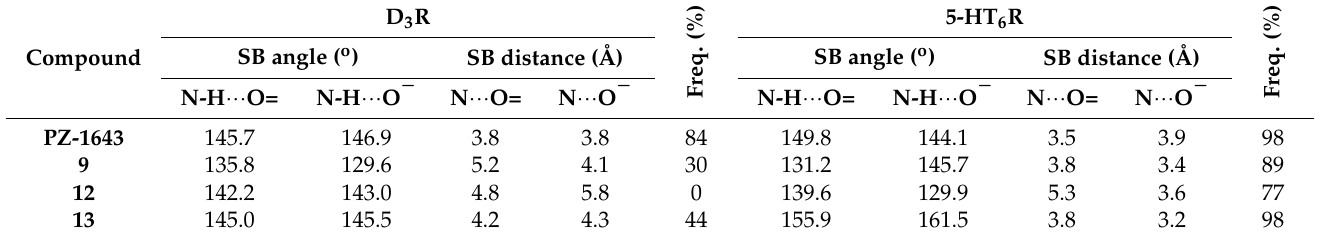
Table 3. The mean geometric parameters of the salt bridge (SB) between basic nitrogen and carboxylic group of D3.32, observed during the molecular dynamics simulations for compounds 9 , 12 , 13, and PZ-1643